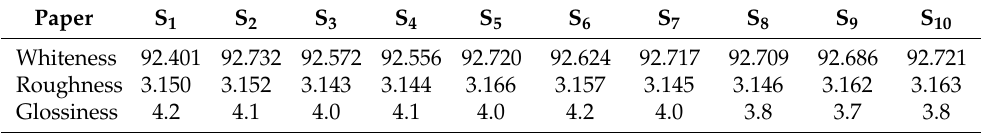
Table 6. Whiteness, roughness, and glossiness of white blocks for all test models.